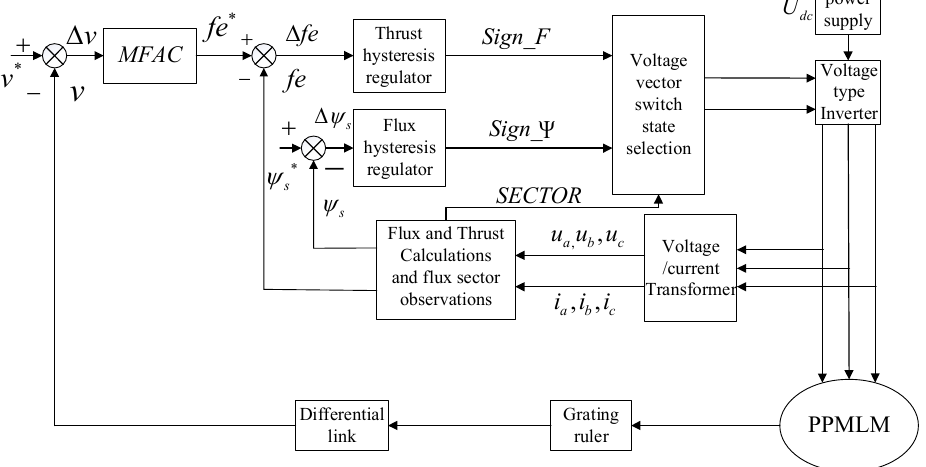
Figure 2. Block diagram of the PPMLM direct thrust force control system based on CFDL−MFAC.